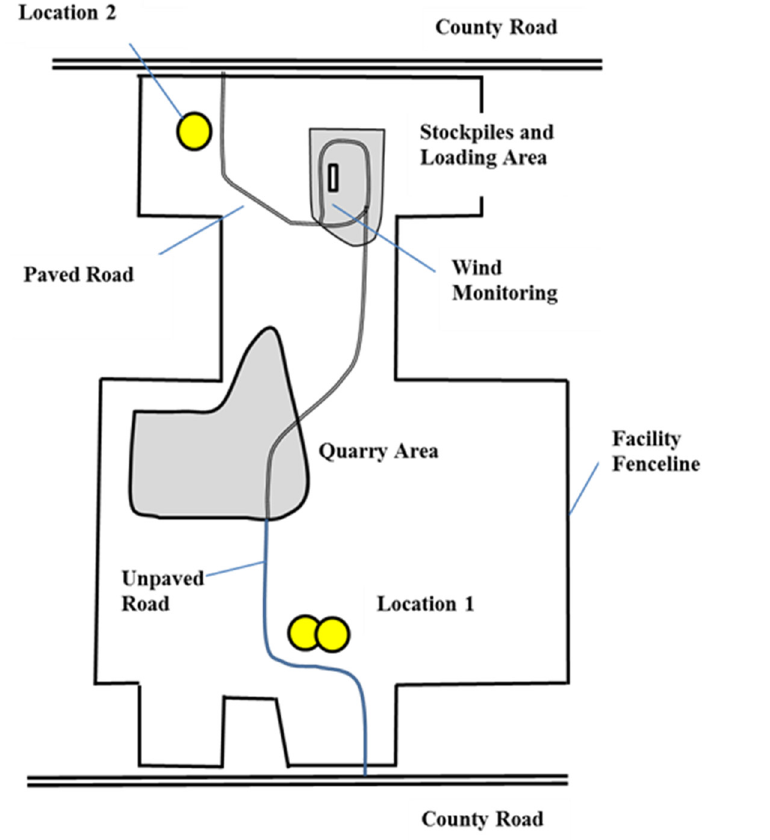
Figure 7. DD Mine sampling locations.